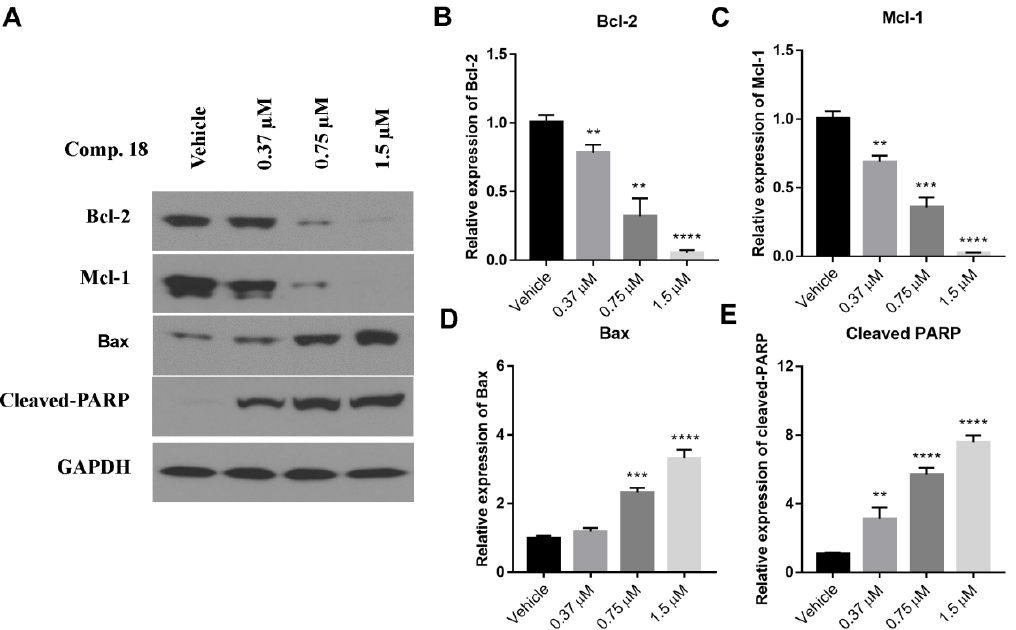
Figure 4. The effect of compound 18 on apoptosis-related proteins in MGC-803 cells. ( A – E ) Expression and quantitative analysis of cleaved-PARP, Mcl-1, Bcl-2, and Bax in MGC-803 cells treated with compound 18 at the different concentrations for 48 h. 0.001 < ** p < 0.01, *** p < 0.001, and **** p < 0.0001 compared to the control group.